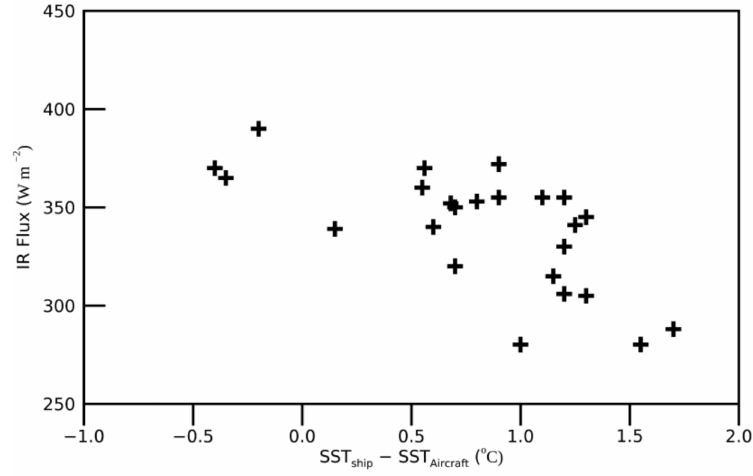
Figure 2. Descending infrared flux depending on the SST difference ( SST ship − SST aircraft ).